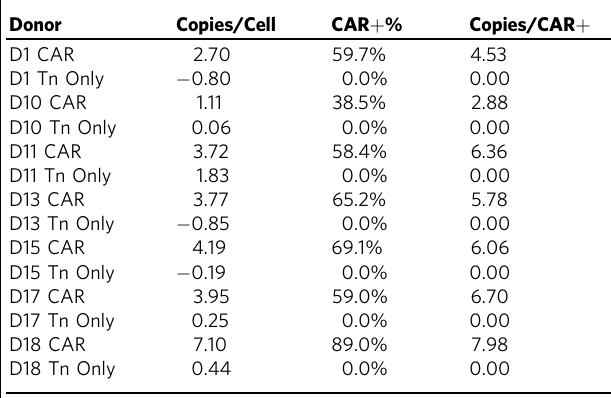
Table 2 BAFF-CAR integration copy number in T